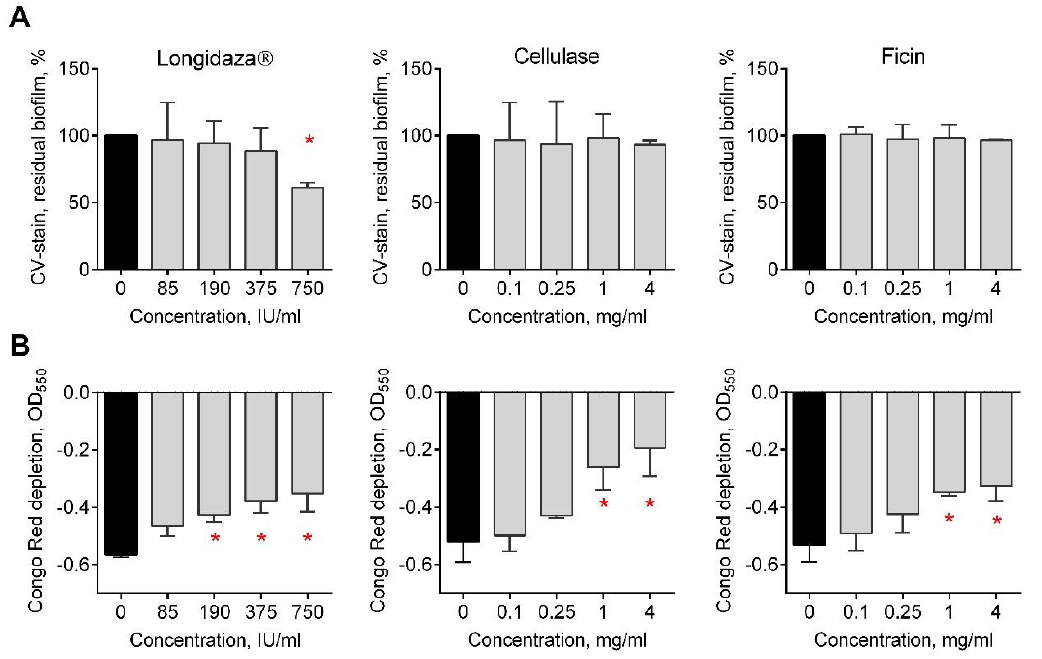
Figure 1. The effect of Longidaza ® , Cellulase, and Ficin on C. albicans K4940 biofilms in vitro. Forty-eight-h-old C. albicans biofilms were washed and incubated 24 h in fresh BM broth supplemented with either 85 − 750 IU of Longidaza ® , 0.1 − 4 mg/mL of Cellulase from Aspergillus niger , or Ficin as indicated. Biofilms were quantified with either ( A ) crystal violet staining or ( B ) Congo Red depletion assay. Asterisks denote significant difference with untreated samples (* p < 0.05).